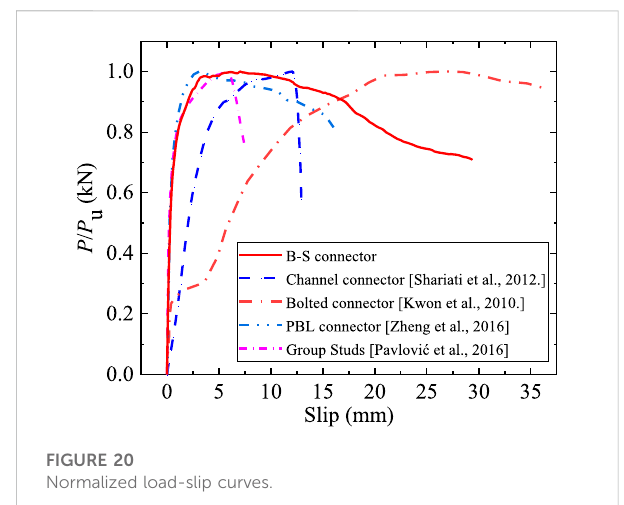
Normalized load-slip